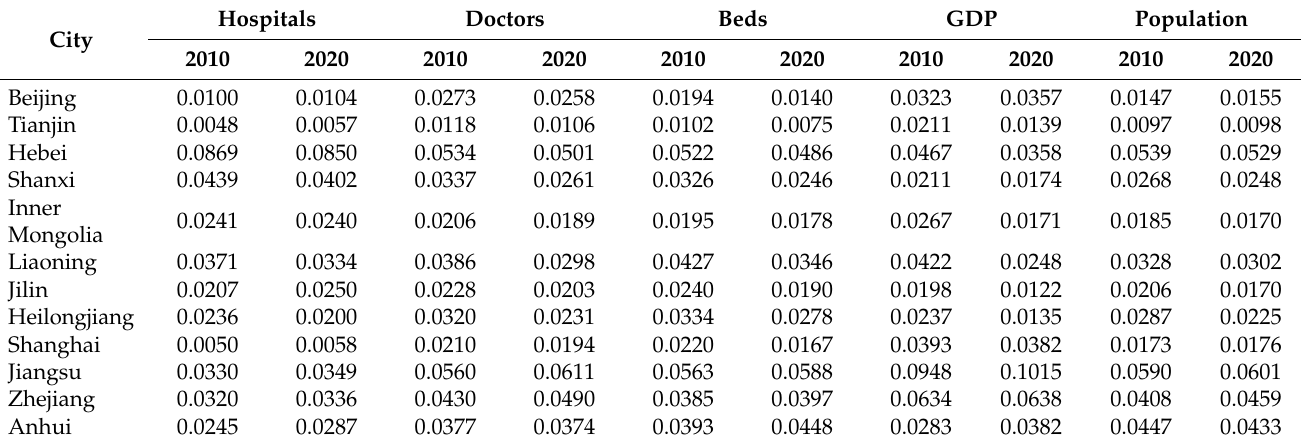
Table A1. Dependent, demand, and supply variable data, based on sum standardization